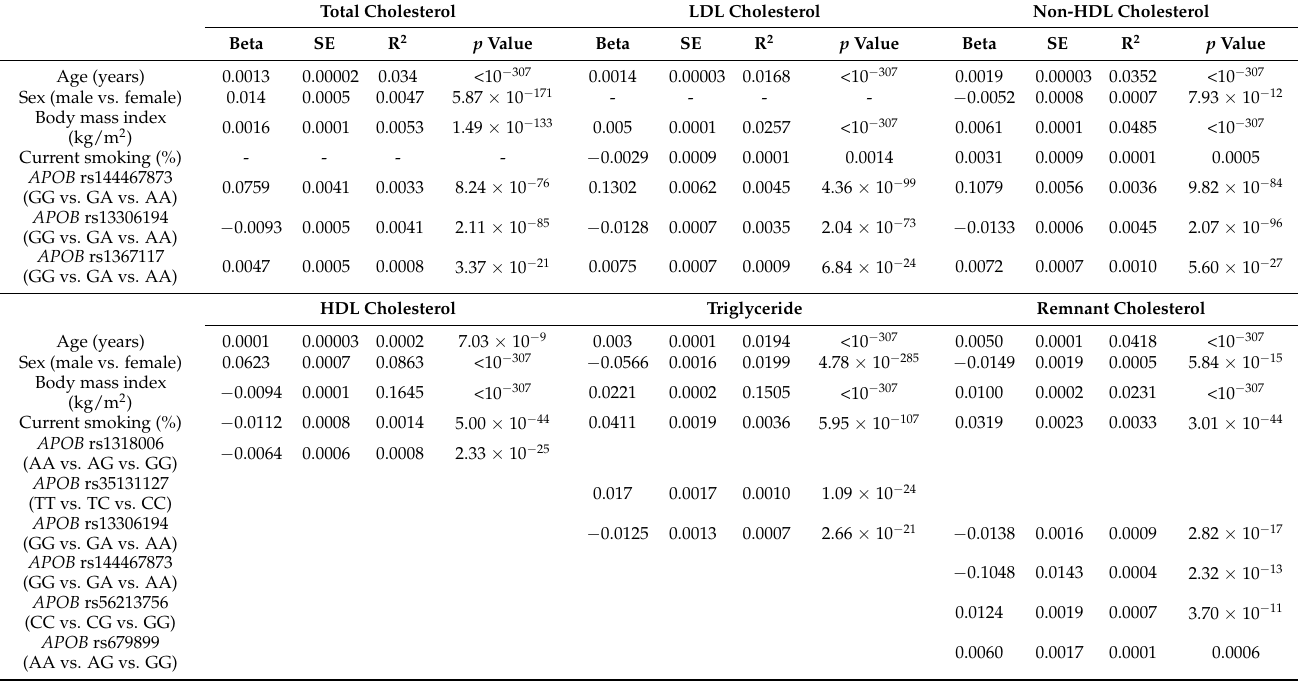
Table 3. Stepwise linear regression analysis: lipid profiles.